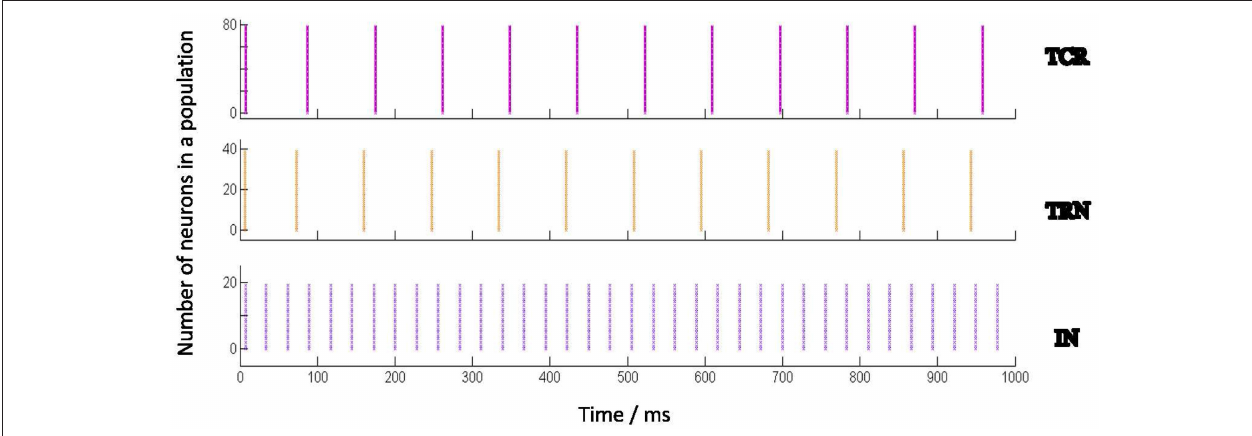
FIGURE 2 | Behavior of the Izhikevich model neurons when acting independently (i.e., not connected to one another) and stimulated by a constant input current ( I dc ). Each Izhikevich model neuron simulating a TCR and TRN cell is parameterized to fire in a Regular Spiking (RS) mode corresponding to I dc , while each IN cell is parameterized to fire in a Fast Spiking (FS) mode. The corresponding parameters are mentioned in Table 2 . The case for I dc = 5 nA is shown here. The Implementation of the Izhikevich neuronal models are as defined in PyNN ( Davison et al., 2009) and mapped on SpiNNaker by the underlying toolchain sPyNNaker version 3.0.0 ( Stokes et al., 2017). I dc forms part of the Izhikevich neuron definition on sPyNNaker, therefore acting as current stimulus to each neuron model from the start of simulation time. The raster plots show that all neurons in a certain population, when acting independently, respond similarly to a stimulus in terms of spike times and